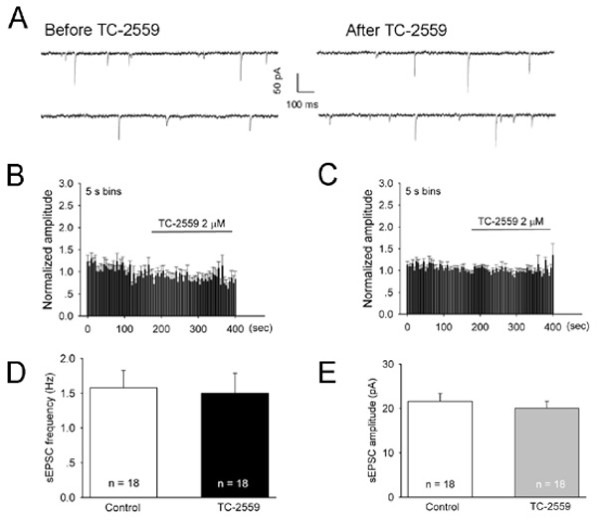
TC-2559 has no effect on sEPSCs in the superficial dorsal horn of the spinal cord slices. A, Whole-cell voltage-clamp (Vh = -70 mV) recording of sEPSCs in a SG neuron before and after bath application of 2 μM TC-2559. B-C, Normalized rate histogram showing the mEPSC frequency (B) and amplitude (C) before and during bath application of 2 μM TC-2559 (n = 18). D-E, 2 μM TC-2559 had no significant effect on both the frequency (D, P = 0.3065, n = 18) and amplitude (E, P = 0.7442, n = 18) of sEPSC (Paired t test).